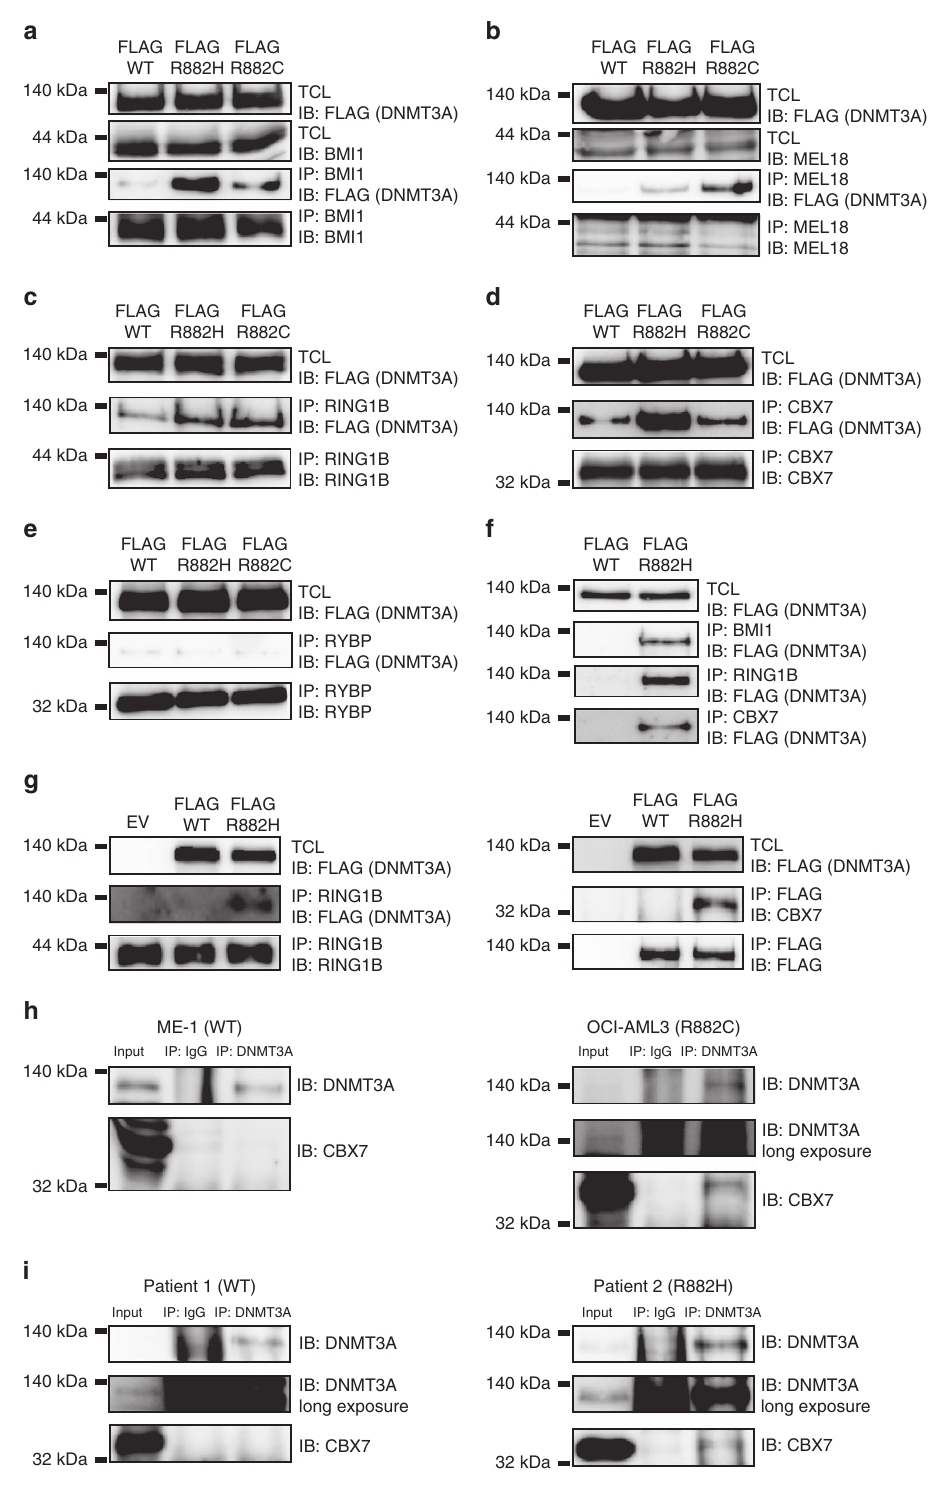
Figure 3 | DNMT3A R882 mutant specifically interacts with PRC2-dependent PRC1. ( a – e ) Extracts from HEK293T cells transfected with FLAG-WT or -R882 mutants are immunoprecipitated with anti-BMI1 ( a ), MEL18 ( b ), RING1B ( c ), CBX7 ( d ) or RYBP ( e ) antibody and are immunoblotted with anti- FLAG antibody. ( f ) Benzonase-treated lysates were immunoprecipitated with anti-BMI1, RING1B and CBX7 antibody, and were immunoblotted with anti- FLAG antibody. ( g ) Immunoprecipitation experiments between DNMT3A and CBX7 (left) or RING1B (right) using FLAG-tagged WT- or R882H-transduced HL60 cells. ( h ) Endogenous DNMT3A proteins extracted from ME-1 (DNMT3A WT) and OCI-AML3 (R882C) were immunoprecipitated, followed by immunoblotting with anti-CBX7 antibody. Normal rabbit IgG was used as a negative control. ( i ) Interactions between endogenous DNMT3A and CBX7 in primary leukaemia cells from DNMT3A-intact AML (left; patient 1 (WT)) and DNMT3A-mutated AML (right; patient 2 (R882H)). Normal rabbit IgG was used as a negative control. WT, wild type.